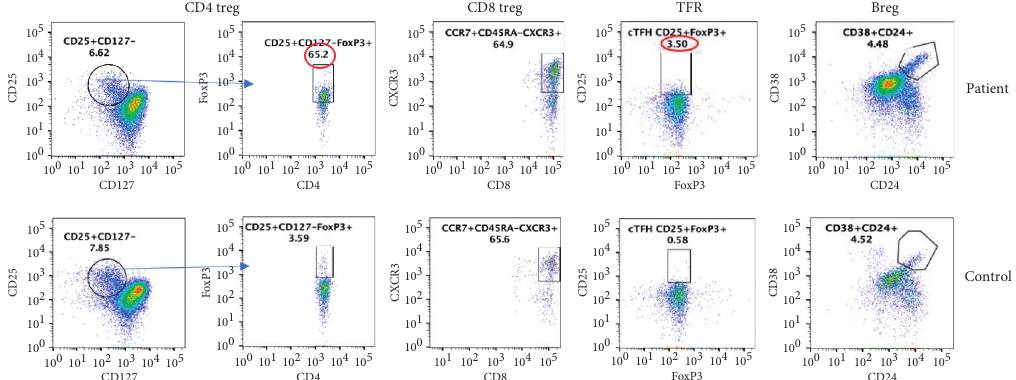
Figure 5: Regulatory lymphocytes: CD4Treg gated CD4+ cells for CD25+CD127- and then analyzed as CD4+CD25+CD127-Foxp3+ cells. Abnormal values are circled in red. CD8 Treg: gated CCR7+CD25highCD45RA- CD8 Tcells expressing CD183 (CXCR3) and FoxP3. TFR cells were characterized as TFR-CD4+CCR5+CD45RA-CD25highFoxP3+ and Breg as